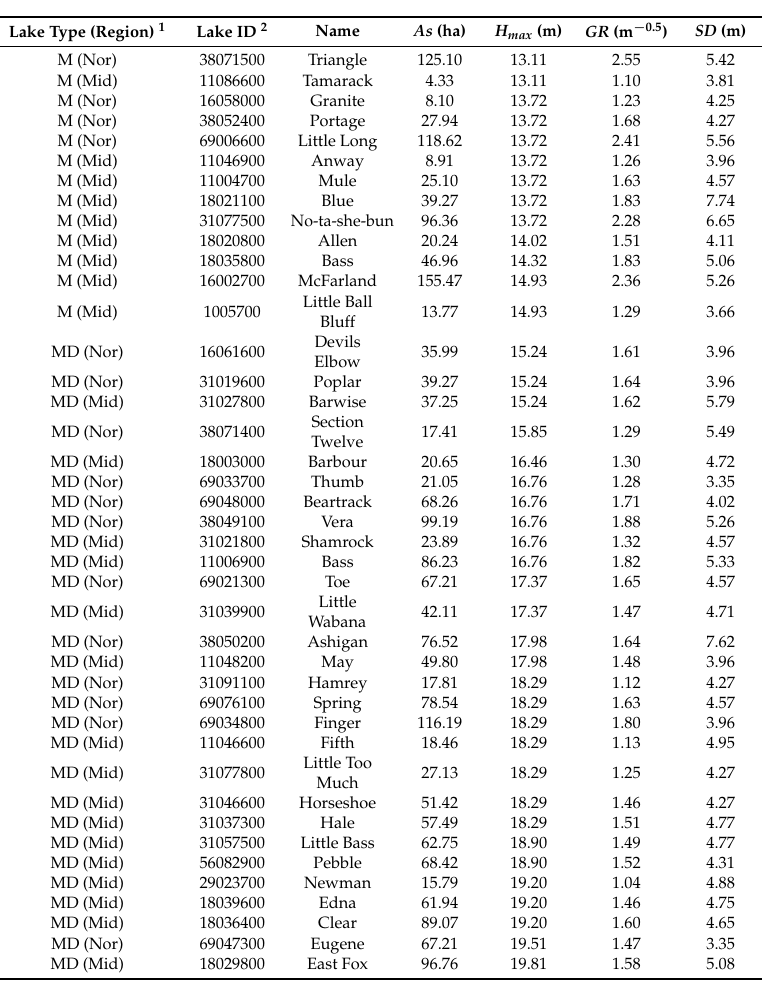
Table A1. Forty cisco lakes and geometry characteristics with different refuge lake classifications using the previous and current